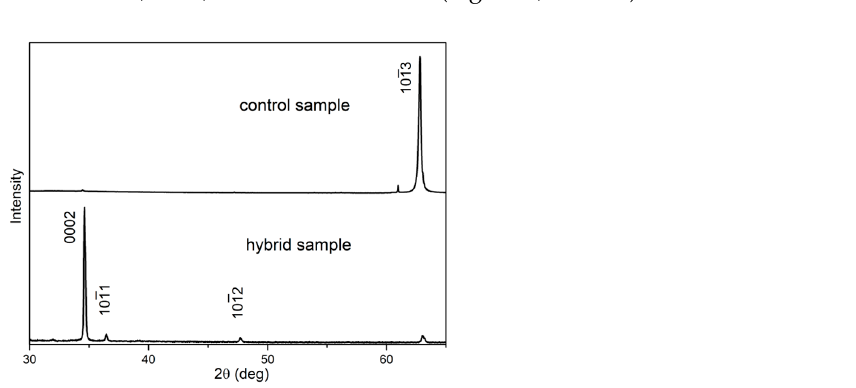
Figure 2. XRD patterns of ZnO structures grown on the M plane of sapphire: Hybrid sample (bottom), control sample (top).